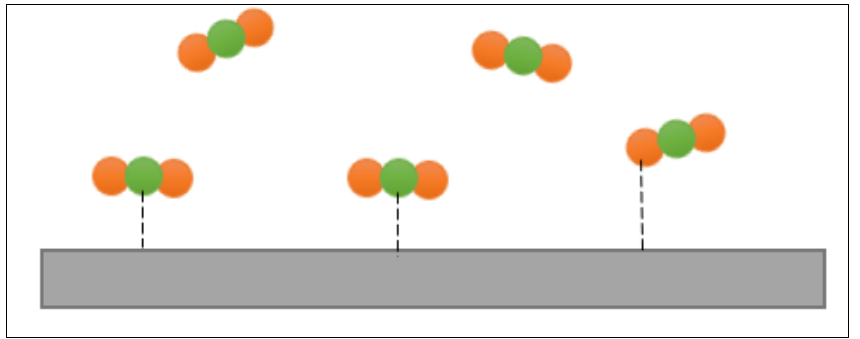
Figure 8. Illustration of physisorption.